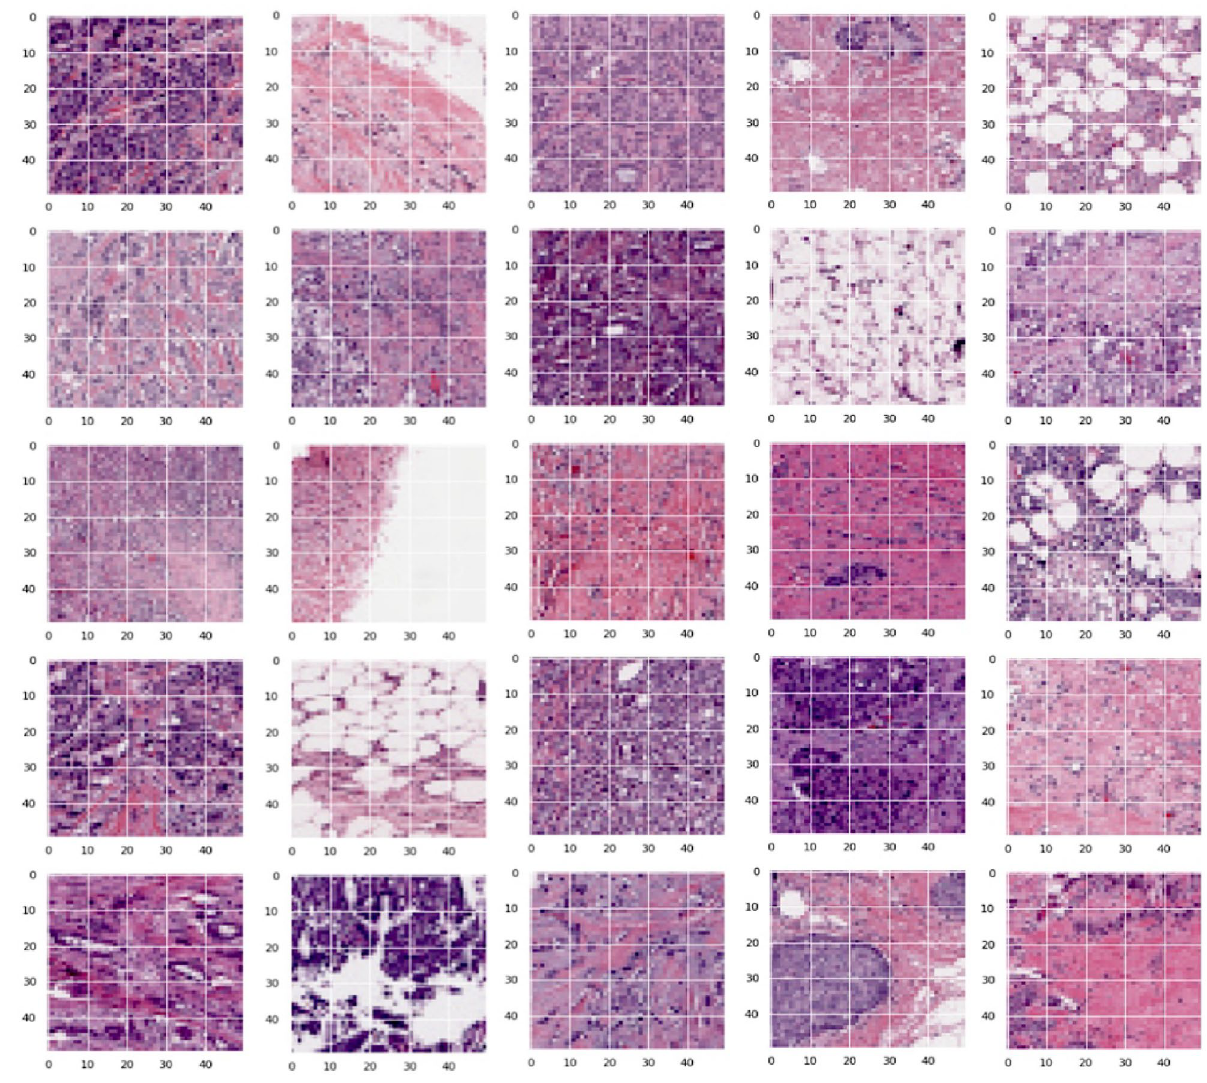
Figure 6. Sample images are part of the IDC